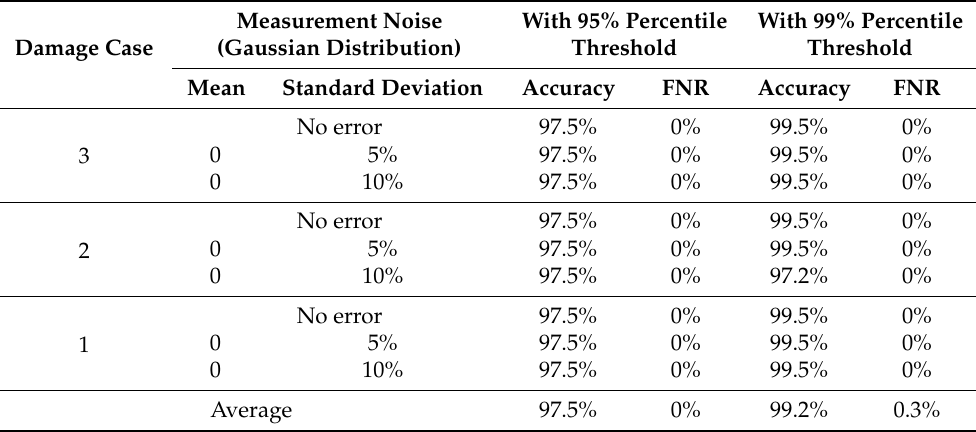
Table 6. Accuracies and FNRs of the CAE models corresponding to three levels of measurement errors and damage severity for RC-slab-bridge